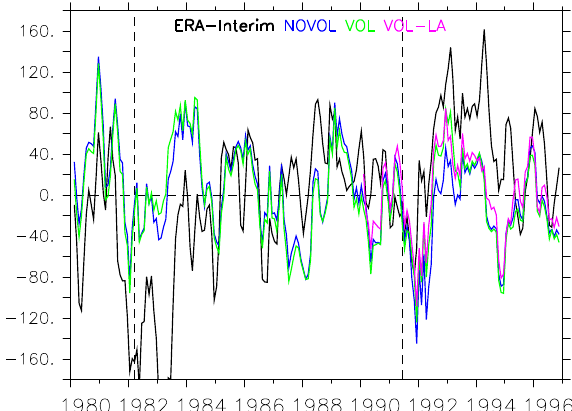
Figure 3. Anomaly of the monthly and zonally averaged tropical (20 ◦ S–20 ◦ N) water vapour (ppmv) at 80hPa calculated from ERA- Interim (black) and as simulated in the NOVOL (blue) and VOL (green) simulations. The purple line (VOL-LA) shows the result of a sensitivity simulation (Mount Pinatubo period, only), for which the stratospheric aerosol extinction was scaled by a factor of 0.5. The anomalies have been calculated based on the period 1980–1996 for ERA-Interim, NOVOL, and VOL, and 1990–1996 for VOL-LA, and further smoothed with a box-smoother of 3 months length. The red-line (MSD) shows the anomaly based on the merged satellite data as derived by Hegglin et al. (2014, their Fig. 2, upper panel). The vertically oriented dashed lines indicate the eruptions of El Chichón (March 1982) and Mount Pinatubo (June 1991).